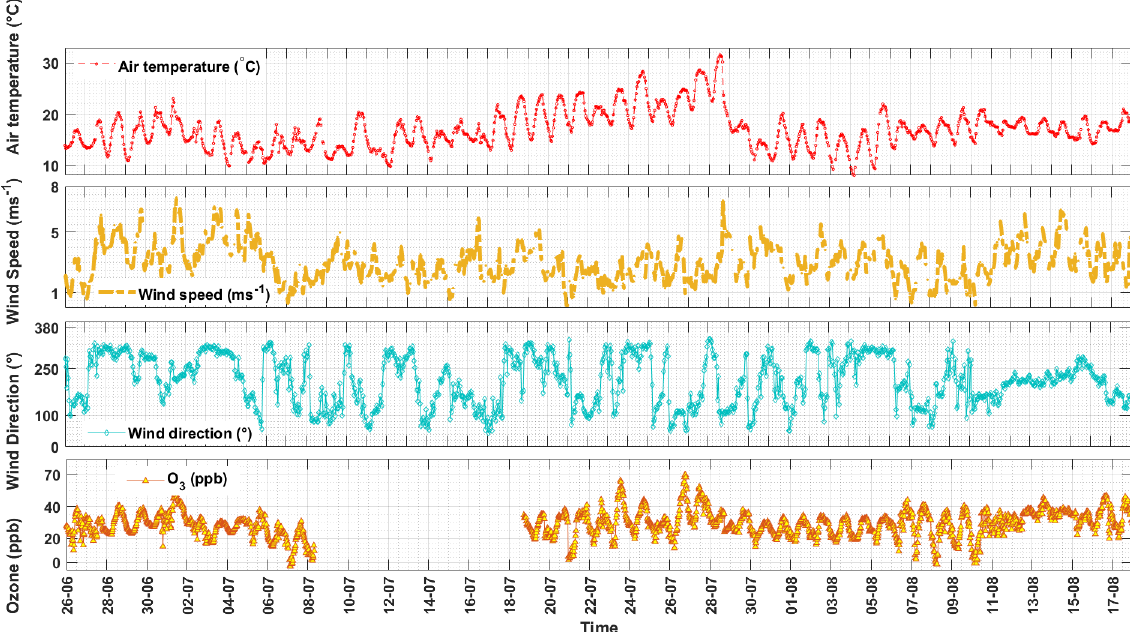
Figure 2. Time series of meteorological parameters and O 3 concentration (data from the SMEAR III station, 30min averaged) during the study